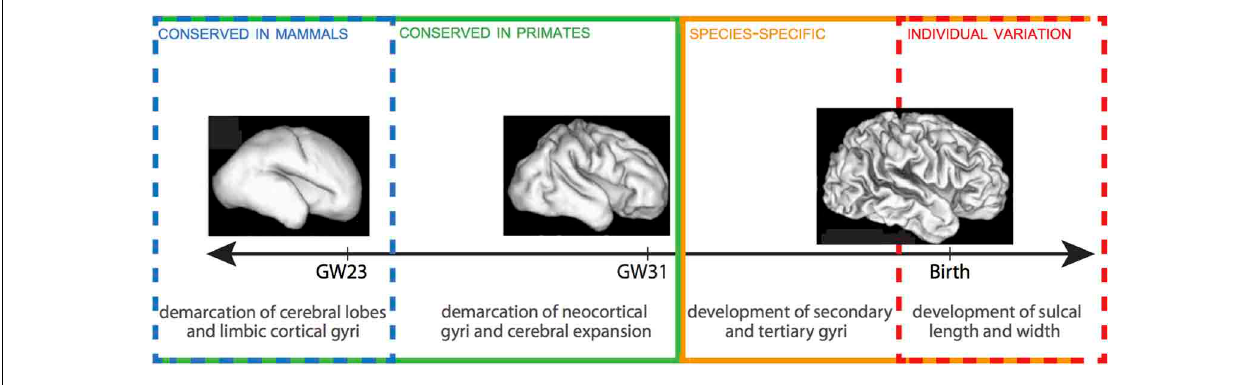
FIGURE 1 | Timeline of gyrification in human. Stages 1 and 2 are delineated by GW 31-32. There is a progressive lack of conservation in cortical folding patterns toward the final stages of gyrification, as minor developmental changes in gyri and sulci become increasingly